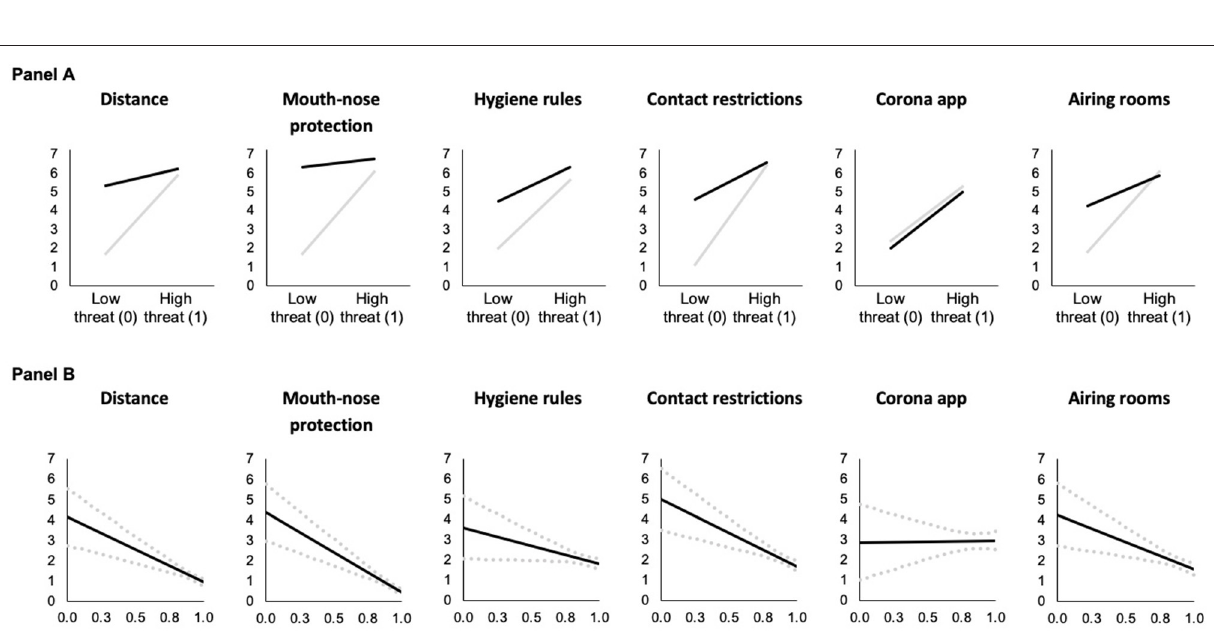
Frontiers in Public Health |